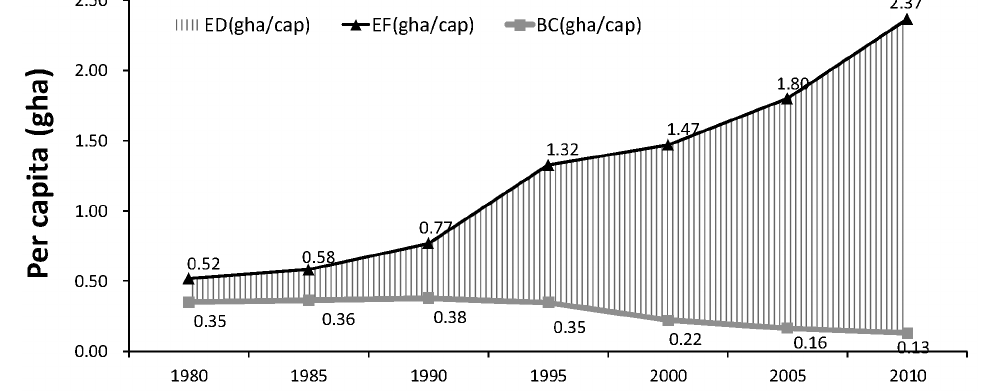
Figure 8. The per capita EF, BC and ED change from 1980 to 2010 in Xiamen City (figure drawn by the